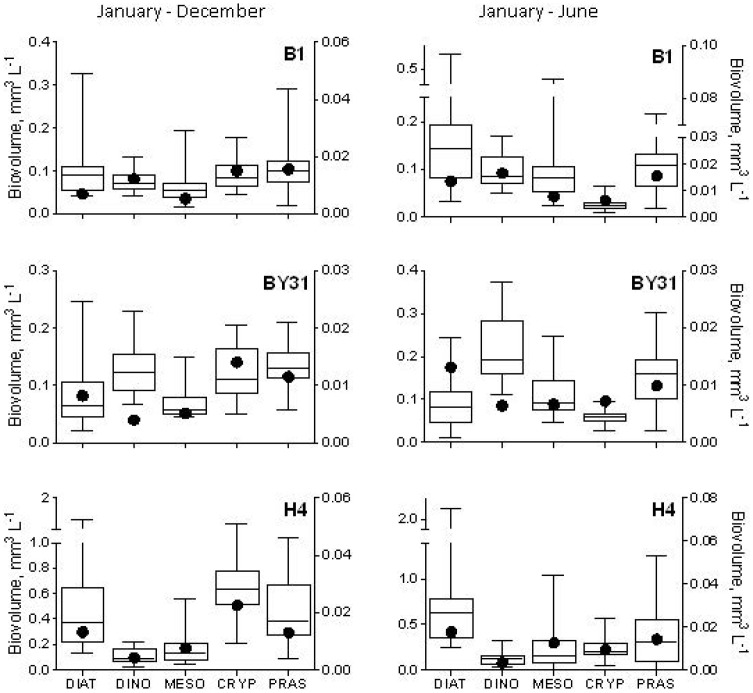
Long-term (1985–2006) variability of group-specific phytoplankton biovolume (mm3 L−1; box and whiskers with mean, 25–75% range, maximum and minimum) and values observed in the year 2008 (filled circles) at three sampling stations (B1, BY31 and H4) in the northern Baltic Proper.Left panels show yearly datasets (January–December; monthly averages) and right panels show winter-spring data only (January–June). Phytoplankton taxa that have been reported to be affected by Prymnesium spp. were included: diatoms (DIAT, left axis), dinoflagellates (DINO, left axis), Mesodinium rubrum (MESO, left axis), cryptophyceans (CRYP, right axis), prasinophyceans (PRAS, right axis). Note the different scales on the left and right Y-axes.